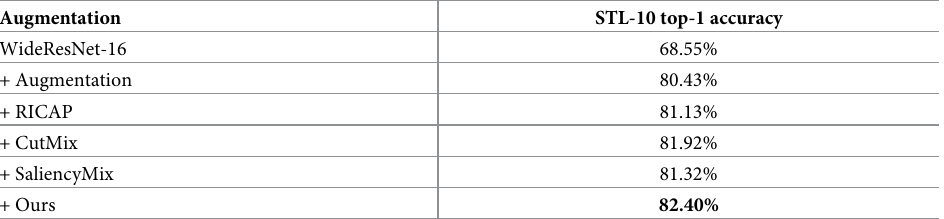
Table 4. Classification performance of the WideResNet-16 architecture on the STL-10